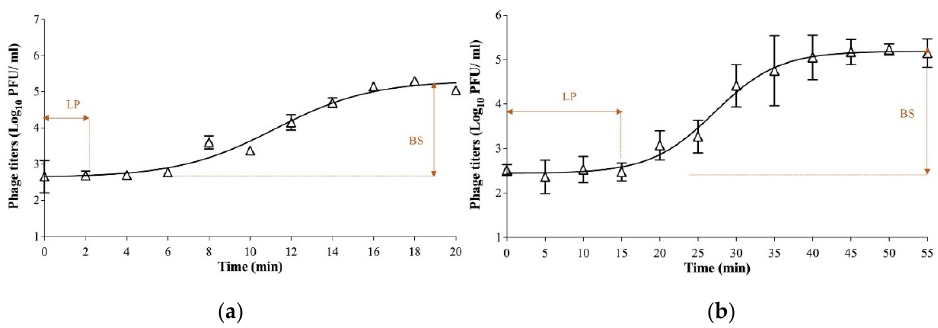
Figure 2. One-step growth curve of the phage Ro103C3lw ( a ) and Pr103Blw ( b ) using E. coli O103:H2 strain (RM10744). The growth parameters of the phage indicate a latent period (LP) and an average burst size (BS) of each phage. The error bars present the standard error of the mean for each time point of the one-step growth